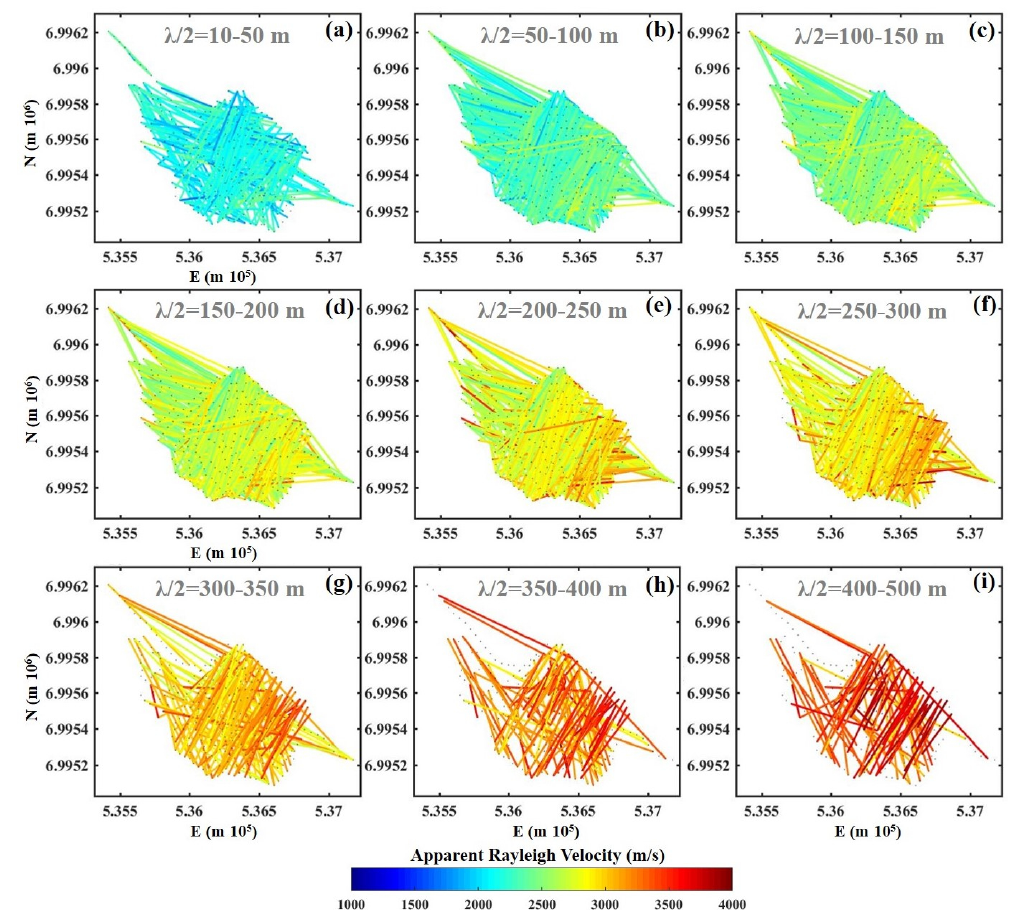
Figure 8. Tomographic pseudoslices at selected half-wavelength (pseudodepth) intervals. (a) 10–50m, (b) 50–100m, (c) 100–150m, (d) 150–200m, (e) 200–250m, (f) 250–300m, (g) 300–350m, (h) 350–400m, (i)